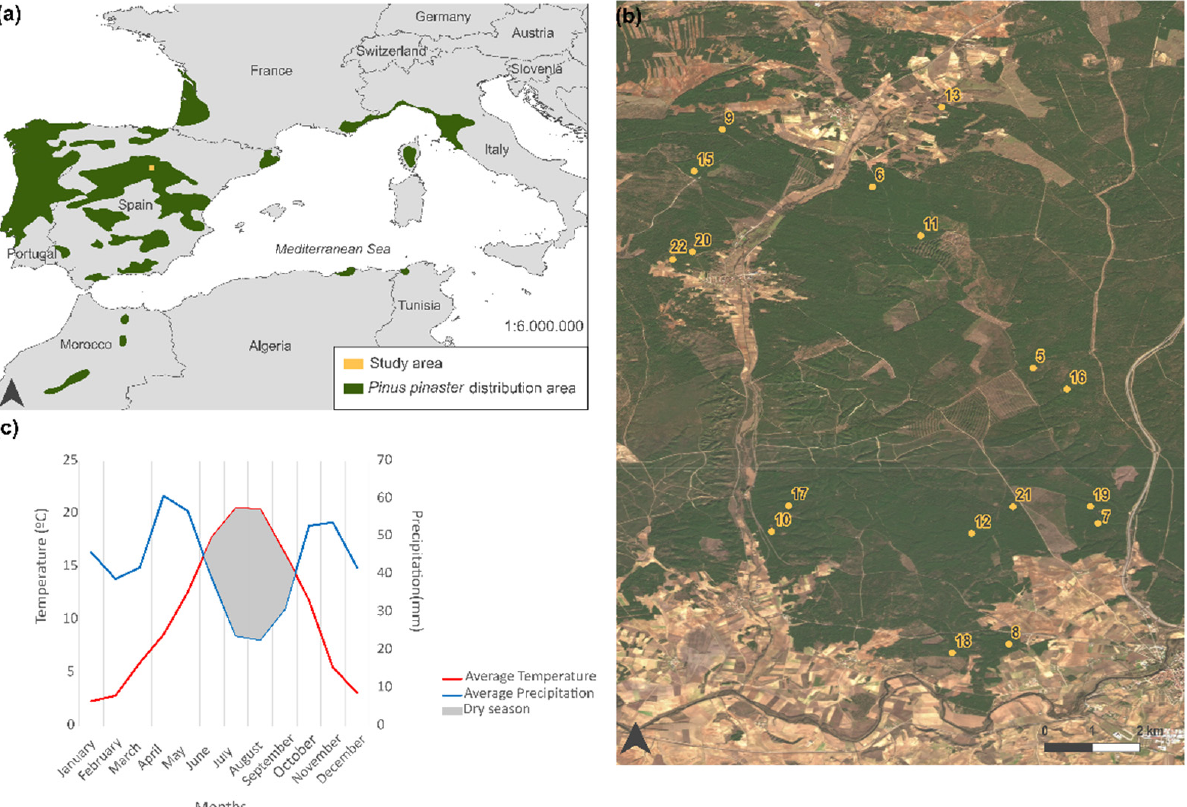
Figure 1. Characterization of the study area: ( a ) overall location in the Mediterranean basin where Pinus pinaster distributes (source: Caudullo et al., 2017) [38]); ( b ) location and distribution of the network of plots (numbered yellow dots); and ( c ) climograph (source: AEMET).